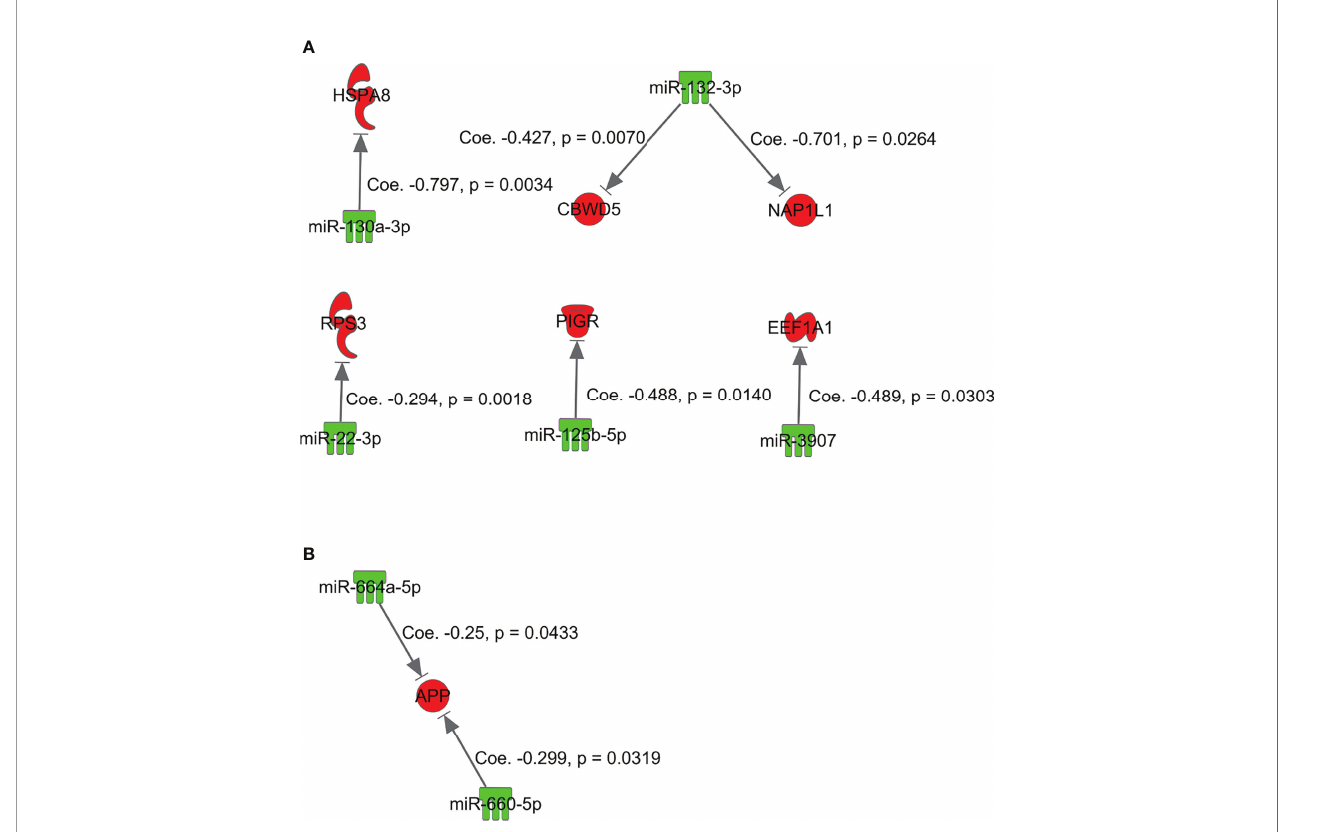
FIGURE 5 | miRNAs and mRNAs with inverse expression patterns in the adenoma component in the array-based assays. (A) miRNA-132-3p/CBWD5 , miRNA- 3907/EEF1A1 , miRNA-130a-3p/HSPA8 , miRNA-132-3p/NAP1L1 , miRNA-125b-5p/PIGR , and miRNA-22-3p/RP53 . (B) miRNA-660-5p and miRNA-664a-5p/APP .